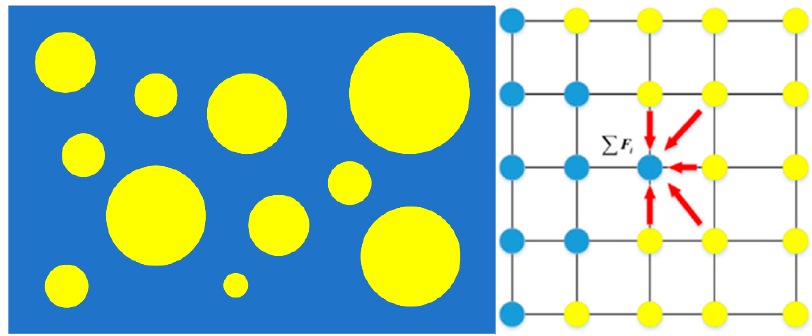
Figure 2. Pseudo-potential force between particles of droplets and the matrix.